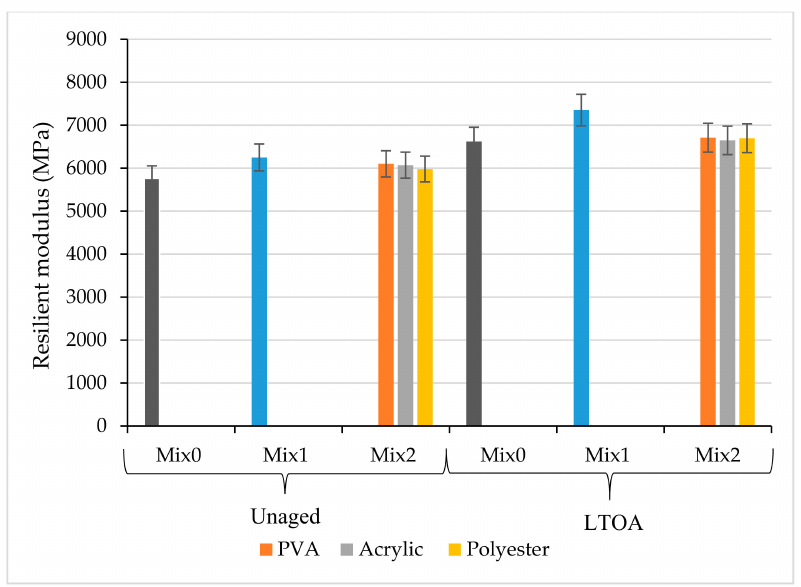
Figure 5. Resilient modulus of the asphalt mixtures at the temperature of 25 ◦ C.